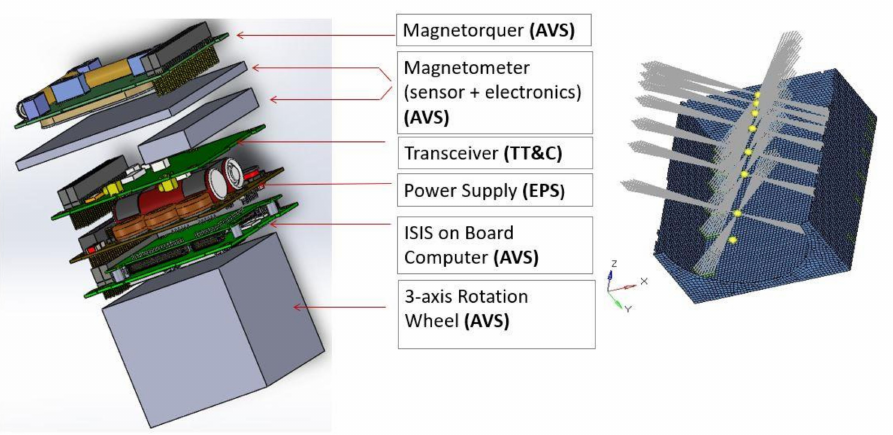
Figure 1. (left) Rendering of internal hardware; (right) Platform structure and internal hardware (equipment/payload) as concentrated Masses (yellow